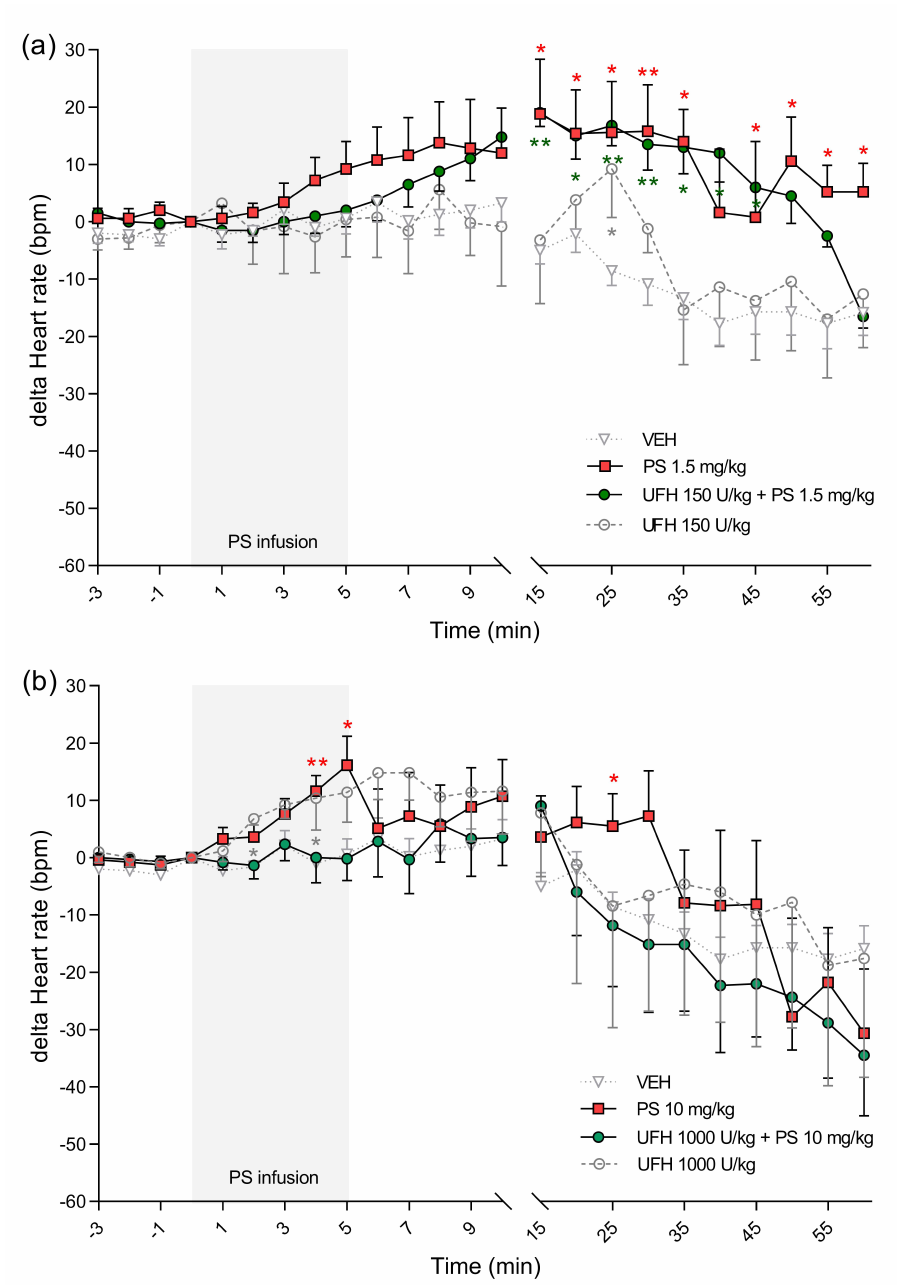
Figure 7. The effects of protamine sulfate (PS) and its complexes with unfractionated heparin (UFH) on heart rate. The course of heart rate was tracked for 60 min after short–duration intravenous infusion (5 min; 2 mL/h) of PS at a dose of 1.5 ( a ) or 10 mg/kg ( b ) following intravenous admin- istration of vehicle (VEH, 1 mL/kg) or UFH (150 or 1000 U/kg, 1 mL/kg). Results are shown as means (lines) with SEMs. The heart rate values at 0 min of the experiment were 438 (365–488) for VEH, 407 (364–438) for PS 1.5 mg/kg, 437 (388–458) for UFH 150 U/kg + PS 1.5 mg, 416 (345–476) for UFH 150 U/kg, 424 (378–517) for PS 10 mg/kg, 410 (385–432) for UFH 1000 U/kg + PS 10 mg/kg, 390 (308–442) for UFH 1000 U/kg. Note: * p < 0.05, ** p < 0.01 vs. VEH, Kruskal–Wallis ANOVA with Dunn’s post–hoc test, n =